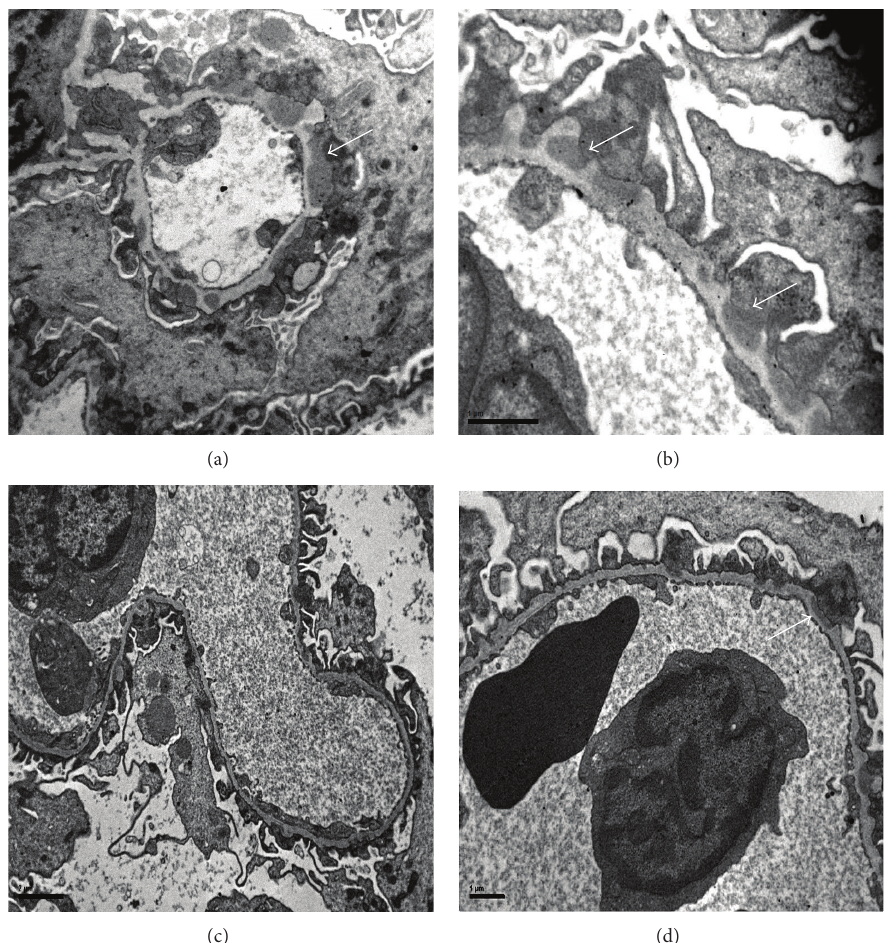
Figure 4: Electron microscopy. (a) Passive Heymann Nephritis. Massive subepithelial deposits (white arrow) with severe fusion of podocyte foot processes; original magnification × 12k. (b) Passive Heymann Nephritis. Subepithelial deposits in higher magnification (white arrows); original magnification × 26k. (c) Passive Heymann Nephritis after rapamycin administration. The deposits and the podocytic injury were attenuated compared to the PHN group; original magnification × 8k. (d) Passive Heymann Nephritis after rapamycin administration (higher magnification × 20 k). Small subepithelial deposit (white